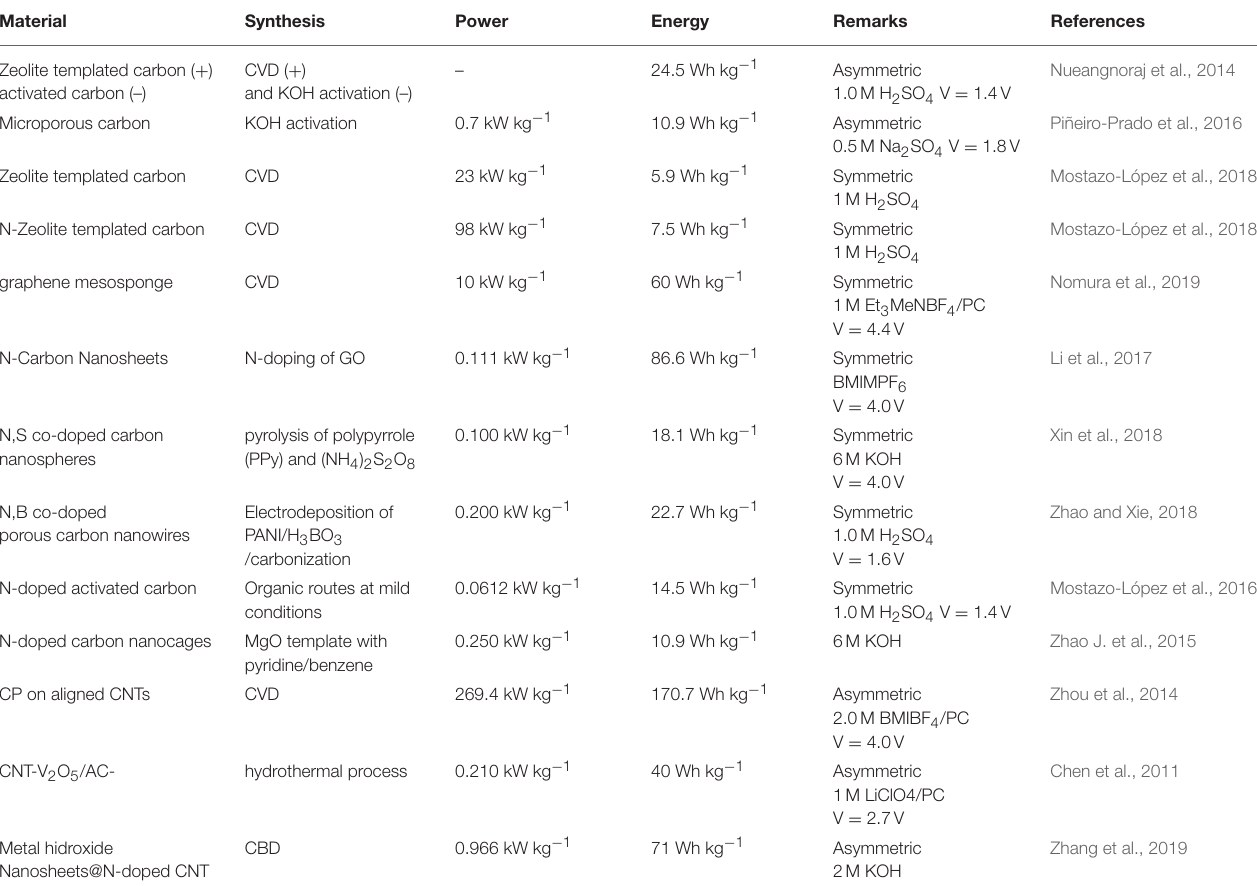
TABLE 1 | Overview of EC based on